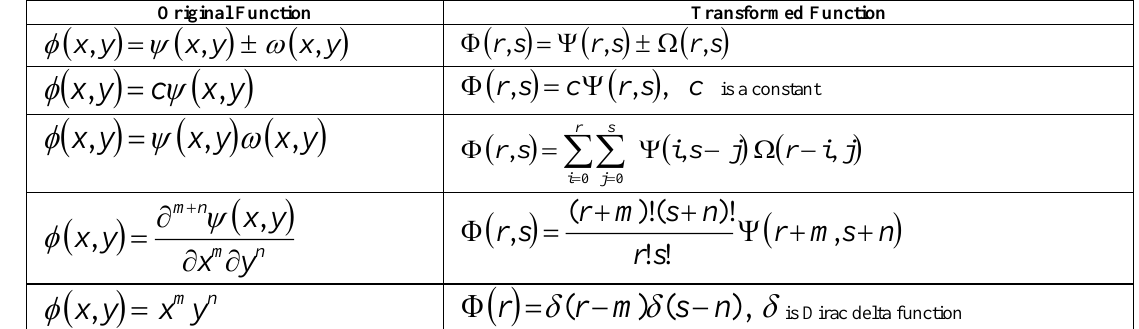
Table 2. Two dimensional differential